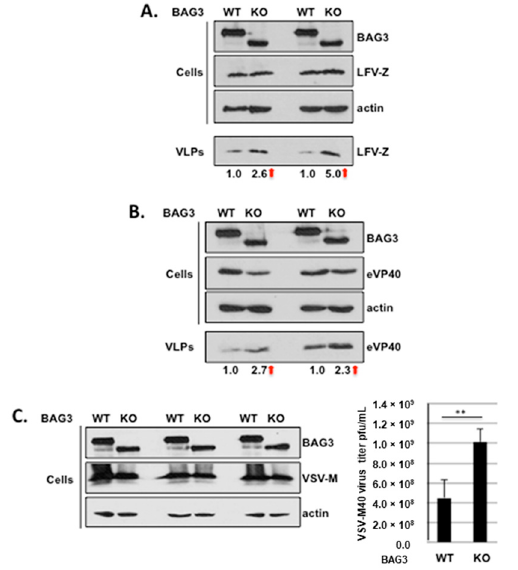
Figure 4. Budding of LFV-Z VLPs, eVP40 VLPs, and VSV-M40 virus from BAG3-WT or BAG3 knockout (KO) cells. ( A ) HAP1-BAG3-WT (WT) or HAP1-BAG3 knockout cells (KO) were transfected with LFV-Z, and the indicated proteins were detected in cell extracts and VLPs by Western blot analysis as shown in two independent experiments; ( B ) HAP1-BAG3-WT (WT) or HAP1-BAG3 knockout cells (KO) were transfected with eVP40, and the indicated proteins were detected in cell extracts and VLPs by Western blot analysis as shown in two independent experiments. The red arrows indicate the fold increase in budding of LFV-Z and eVP40 VLPs in BAG3-KO cells compared to BAG3-WT cells; ( C ) HAP1-BAG3-WT (WT) or HAP1-BAG3 knockout cells (KO) were infected with VSV-M40 recombinant virus, and the indicated proteins were detected in cell extracts by Western blot analysis as shown in three independent experiments. The bar graph depicts the average titers of infectious VSV-M40 virus from three independent experiments. VSV-M40 titers were log10 transformed before checking normality (via Shapiro Wilks normality test) and assessing equality of variance (via F-test). (** p = 0.003).